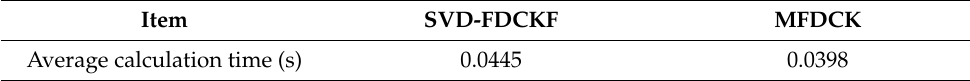
Figure 12. Comparison of simulation time of two algorithms. Table 5. Average simulation time of two